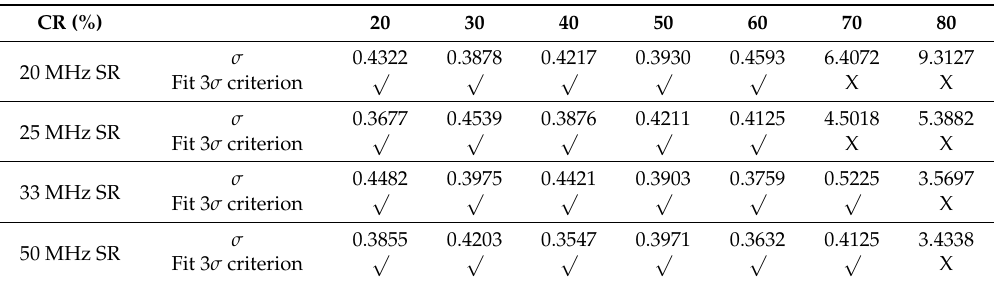
Figure 15a is the original image of 50 MHz SR. The recovered results of 50% CR, 60% CR and